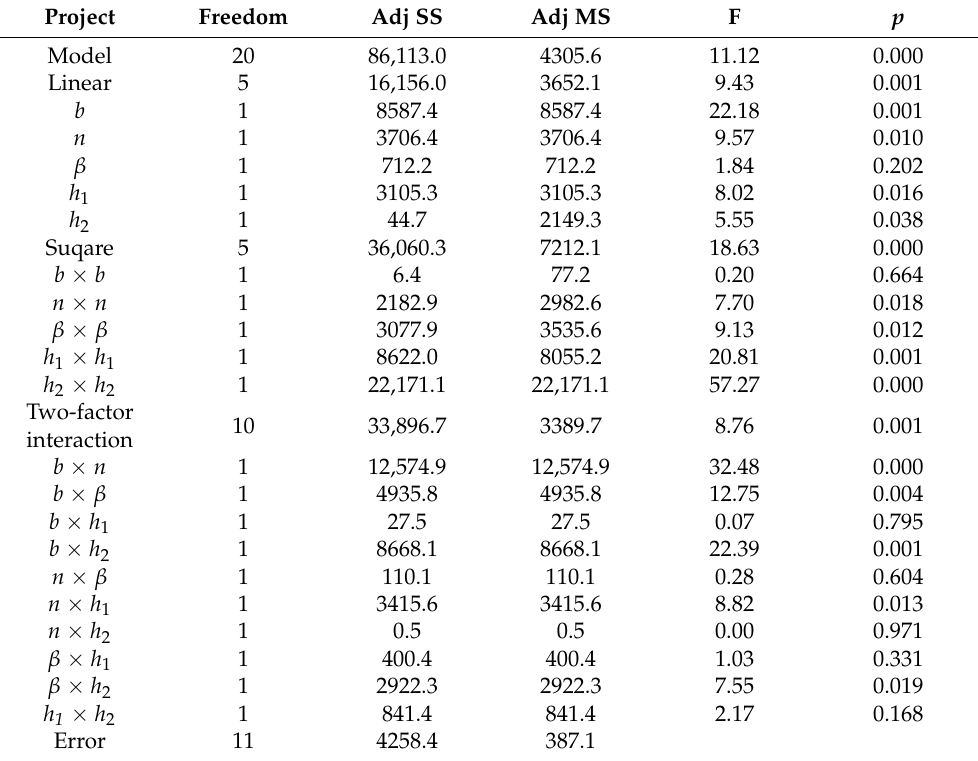
Table 4. ANOVA of droplet volume